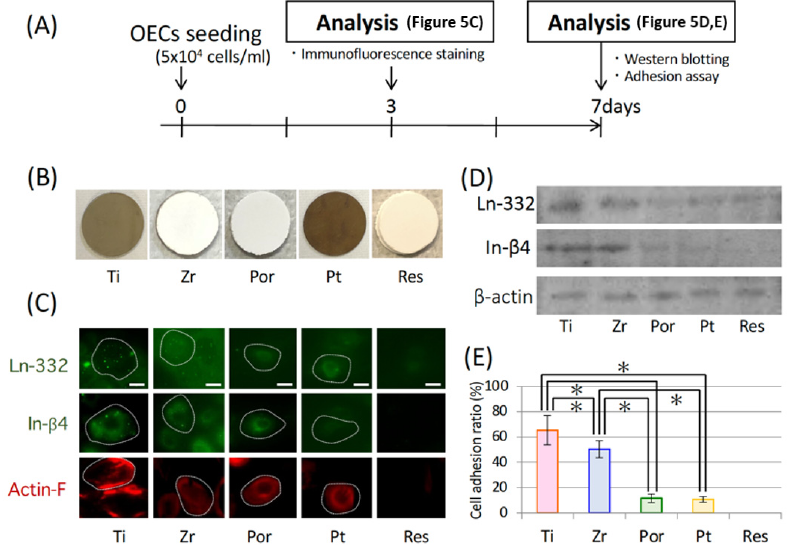
Figure 5. Epithelial cell adhesion on the five materials. ( A ) Experimental protocol for the in vitro study. ( B ) Titanium (Ti), Zirconia (Zr), porcelain (Por), gold-platinum alloy (Pt), and self-curing resin (Res) plates were prepared for culture study as the experimental group. ( C ) Localization of the adhesion-related proteins in the cells on Ti, Zr, Por, Pt, and Res. Bar = 15 µ m. ( D ) Western blotting data. ( E ) Epithelial cell adhesion ratio. Each bar represents the mean ± SD. One-way ANOVA with Scheffe’s post-hoc test; * p < 0.05 between the indicated groups.